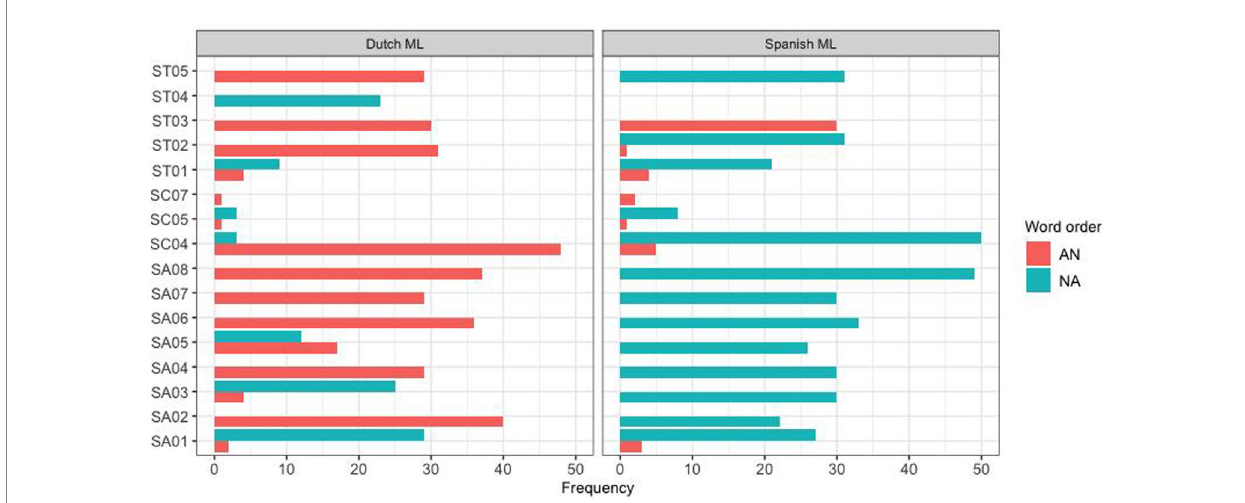
FIGURE 3 Word order production pattern for individual Spanish HSs, separated by the ML.